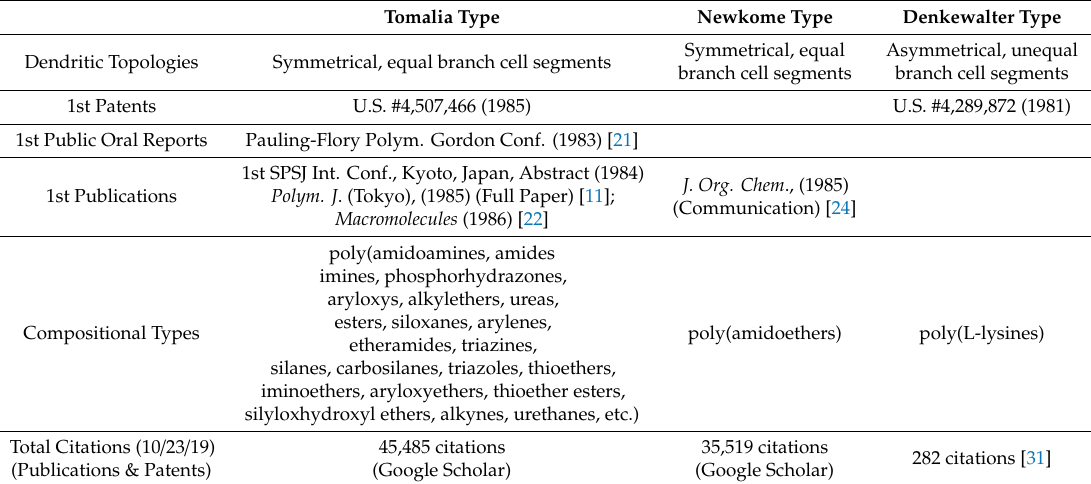
Table 1. Historical comparison of Denkewalter, Tomalia and Newkome first divergent, iterative syntheses of dendritic